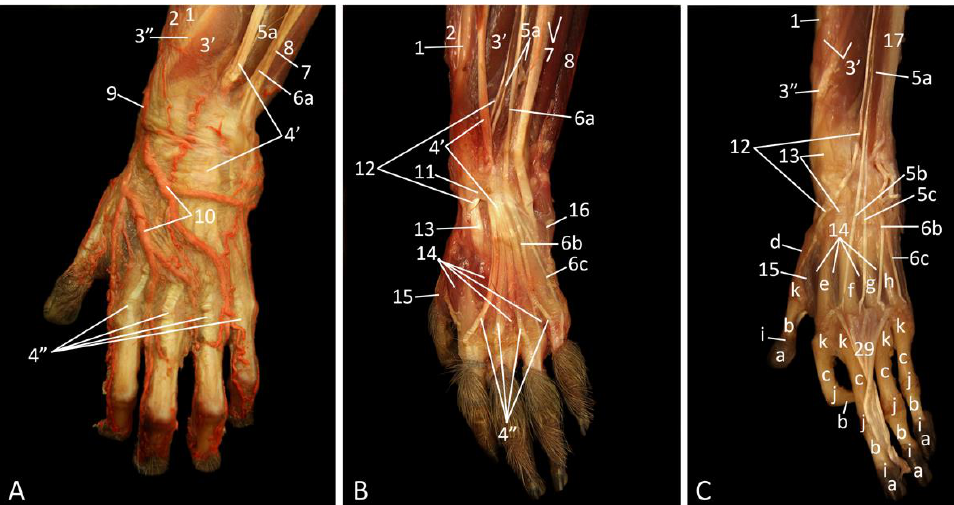
Figure 10. Dorsal view of the left hand; the arterial system is filled with red latex. ( A ): Superficial layer; ( B ): Deeper layer, after the removal of the arcus dorsalis and the deep fascia; ( C ): Deepest layer, after the tendons of the m. extensor digitorum communis have been transected and retracted, and the m. brachioradialis, the m. extensor carpi ulnaris, and the proximal segment of the tendon of the m. extensor digitorum quarti et quinti proprius were